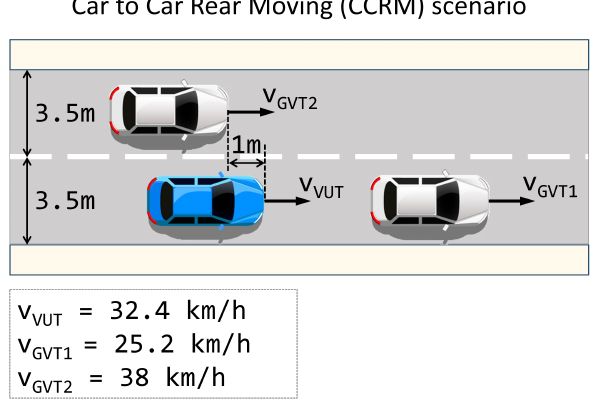
Figure 7. Adaptive cruise control while another vehicle overtakes the ego-vehicle in the side lane scenario. Ego-vehicle is the blue car, and the other agent is the white